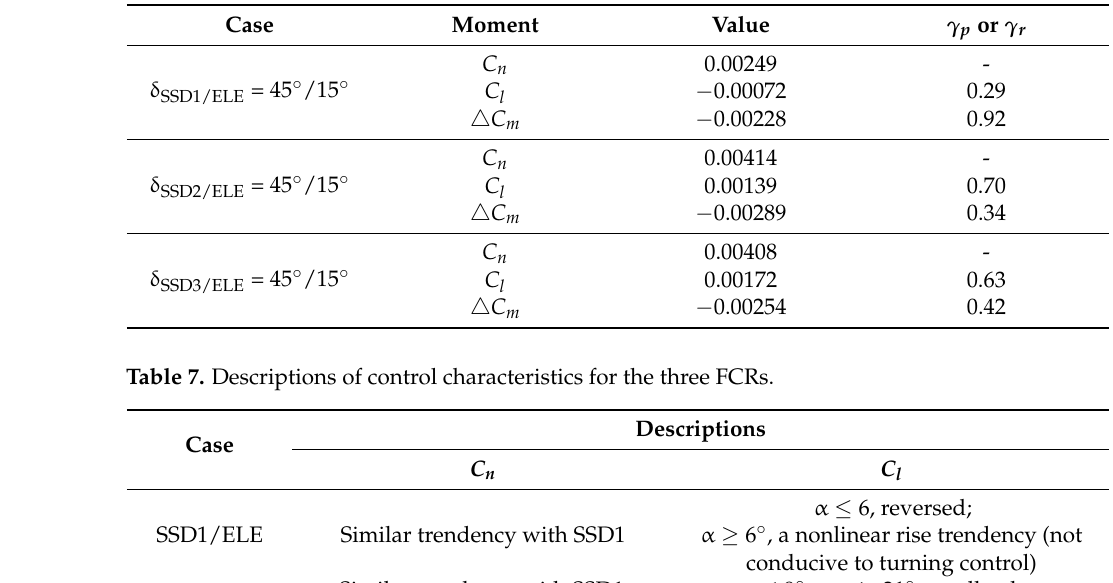
Figure 11. Control characteristics of the different FCRs for Ma = 0.2, Re = 3.98 × 10 7 : ( a ) Pitching moment; ( b ) Rolling and yawing moments. Table 6. Aerodynamic moments characteristics of the FCRs at α = 6 ◦ .